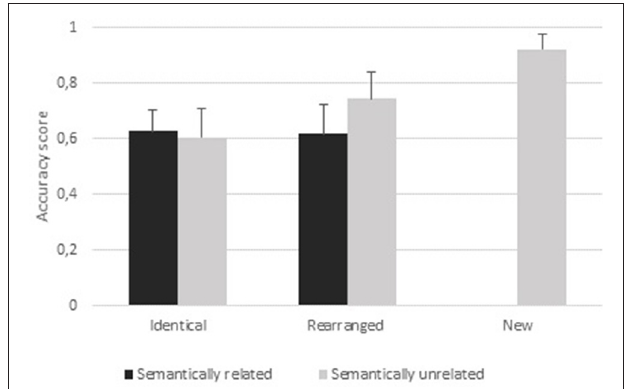
FIGURE 3 | Behavioral results. Accuracy scores per condition (identical pairs, rearranged pairs, new pairs), semantic relation (related, unrelated); errors bars represent standard